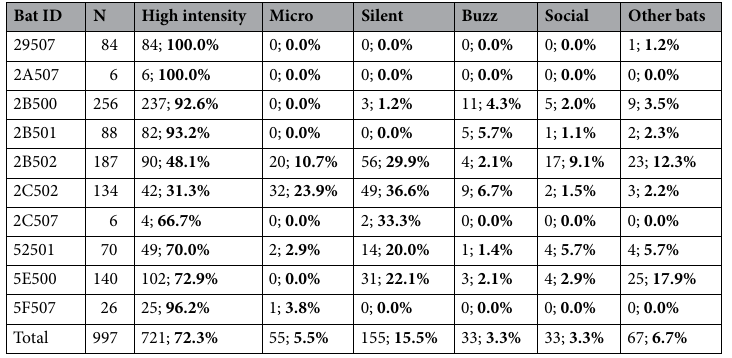
Table 1. Categorization of acoustic behaviors for 10 male hoary bats ( Lasiurus cinereus ) recorded using on-board ultrasonic recording devices. N indicates total number of recordings where it was determined the bat was flying. Data show number and percent of 10-s audio files with high-intensity or micro calls, no detected echolocation (“silent”), feeding buzzes (“buzz”), social interactions indicative of chases (“social”) and echolocation calls recorded from other bats (“Other bats”). Numbers of recordings are shown in normal type, percentages in